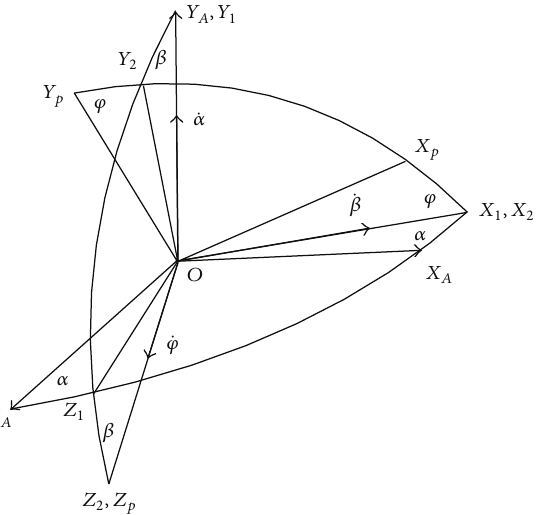
Figure 1: Sequence of rotations determining the platform position.